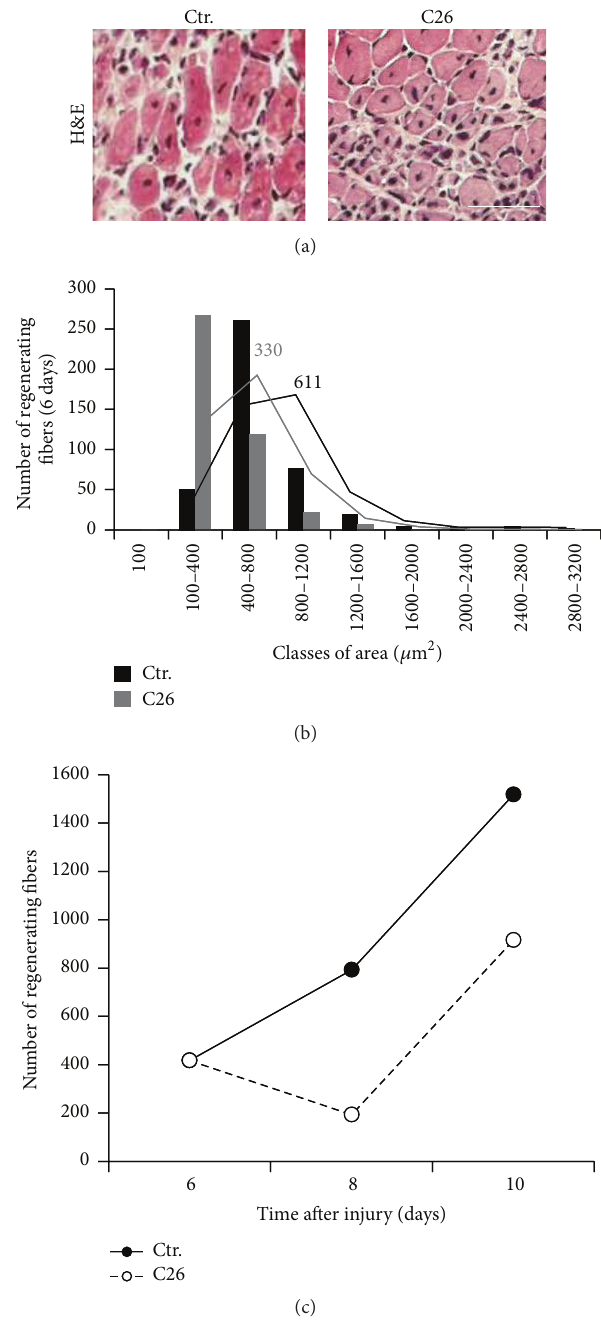
Figure 1: C26-bearing mice show reduced muscle regeneration after acute injury. Panel (a) depicts representative details of H&E-stained muscle cross-cryosections of the lesion sites from both control and C26-bearing mice. Bar = 100 𝜇 m. (b) Morphometric analysis of regenerating fiber size from (a). Histograms show the distribution of the regenerating fiber cross-sectional area in different size classes 6 days after muscle damage (control = black bars; C26-bearing mice = gray bars). Numbers represent the median value. (c) Number of fibers with centrally located nuclei observed in the lesion site of the tibialis from both C26-bearing and control mice after acute damage. The total number of regenerating fibers was monitored at 6, 8, and 10 days after freeze-injury (control = black dots; C26-bearing mice = white